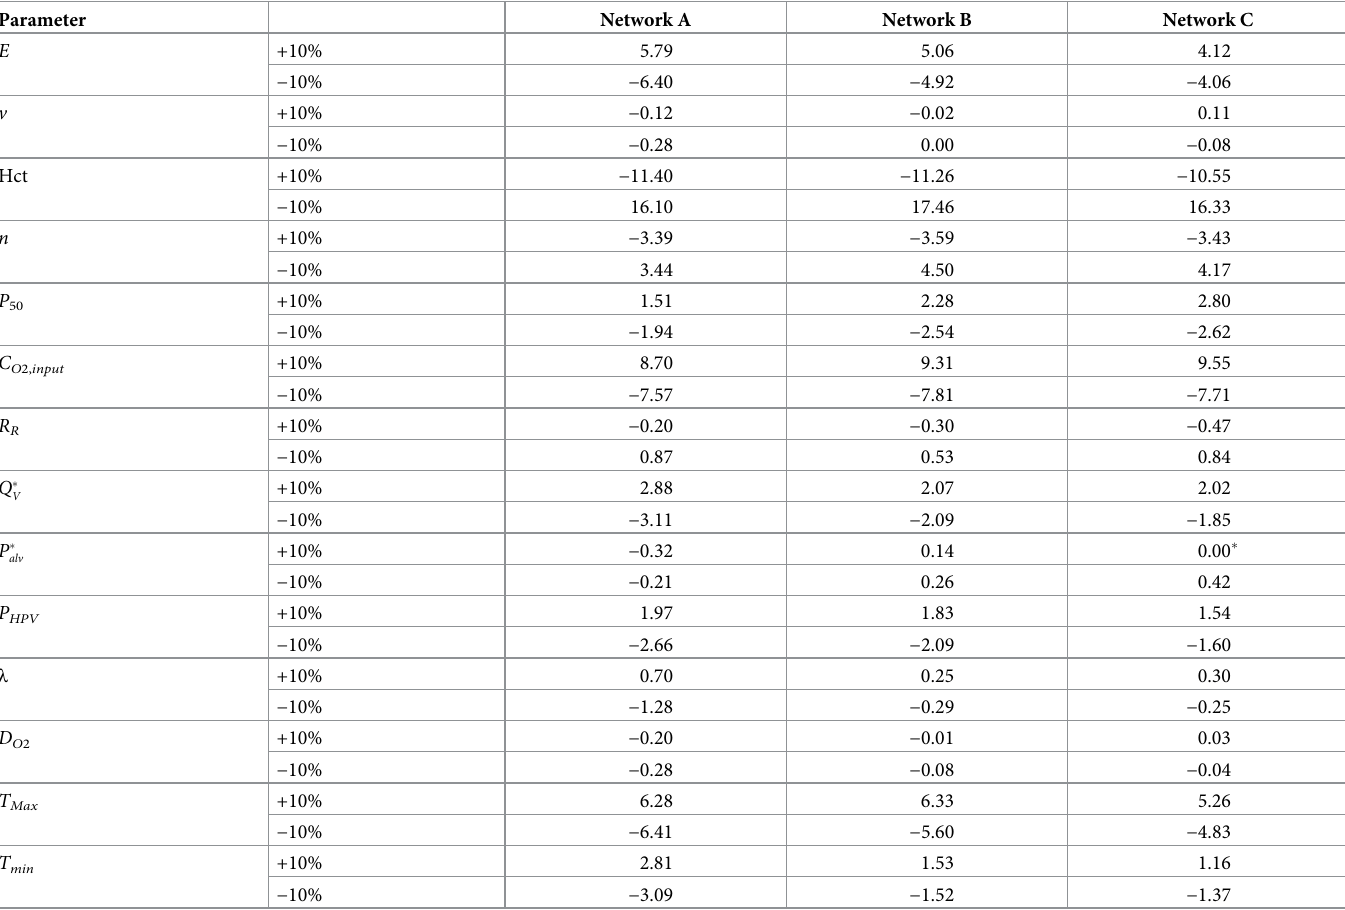
Table 4. Sensitivity analysis. Percent change in oxygen tension of the primary vein given a ± 10% perturbation in nominal parameter value. � —The sensitivity index is less than 0.01.